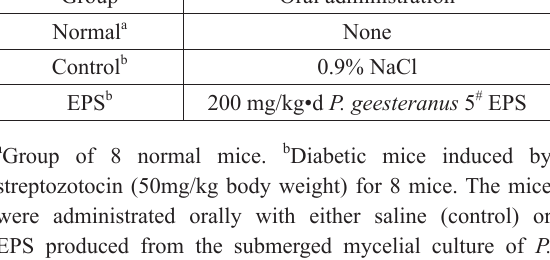
Experimental groups for dose-dependent hypolipidemic activity of P. geesteranus 5 # EPS.